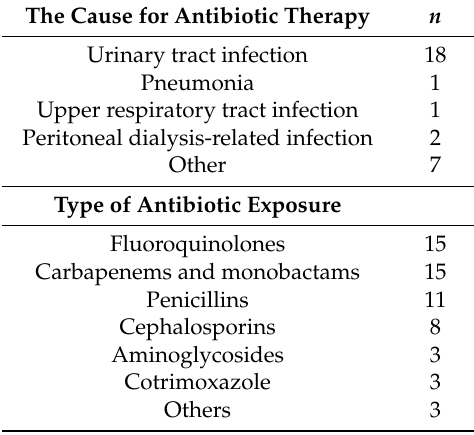
Table 2. Cause of antibiotic therapy and type of antibiotic exposure among CDI patients before the CDI